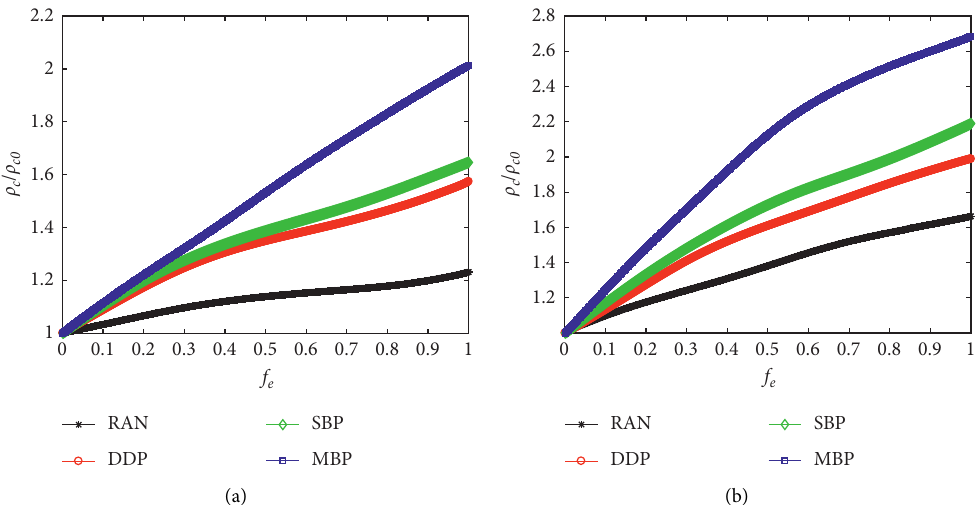
Figure 4: The enhancement of our strategies in multiplex network: (N) � 128, (m) � 8, < (k) > � 16, and (Z) and (b) (Z) in �